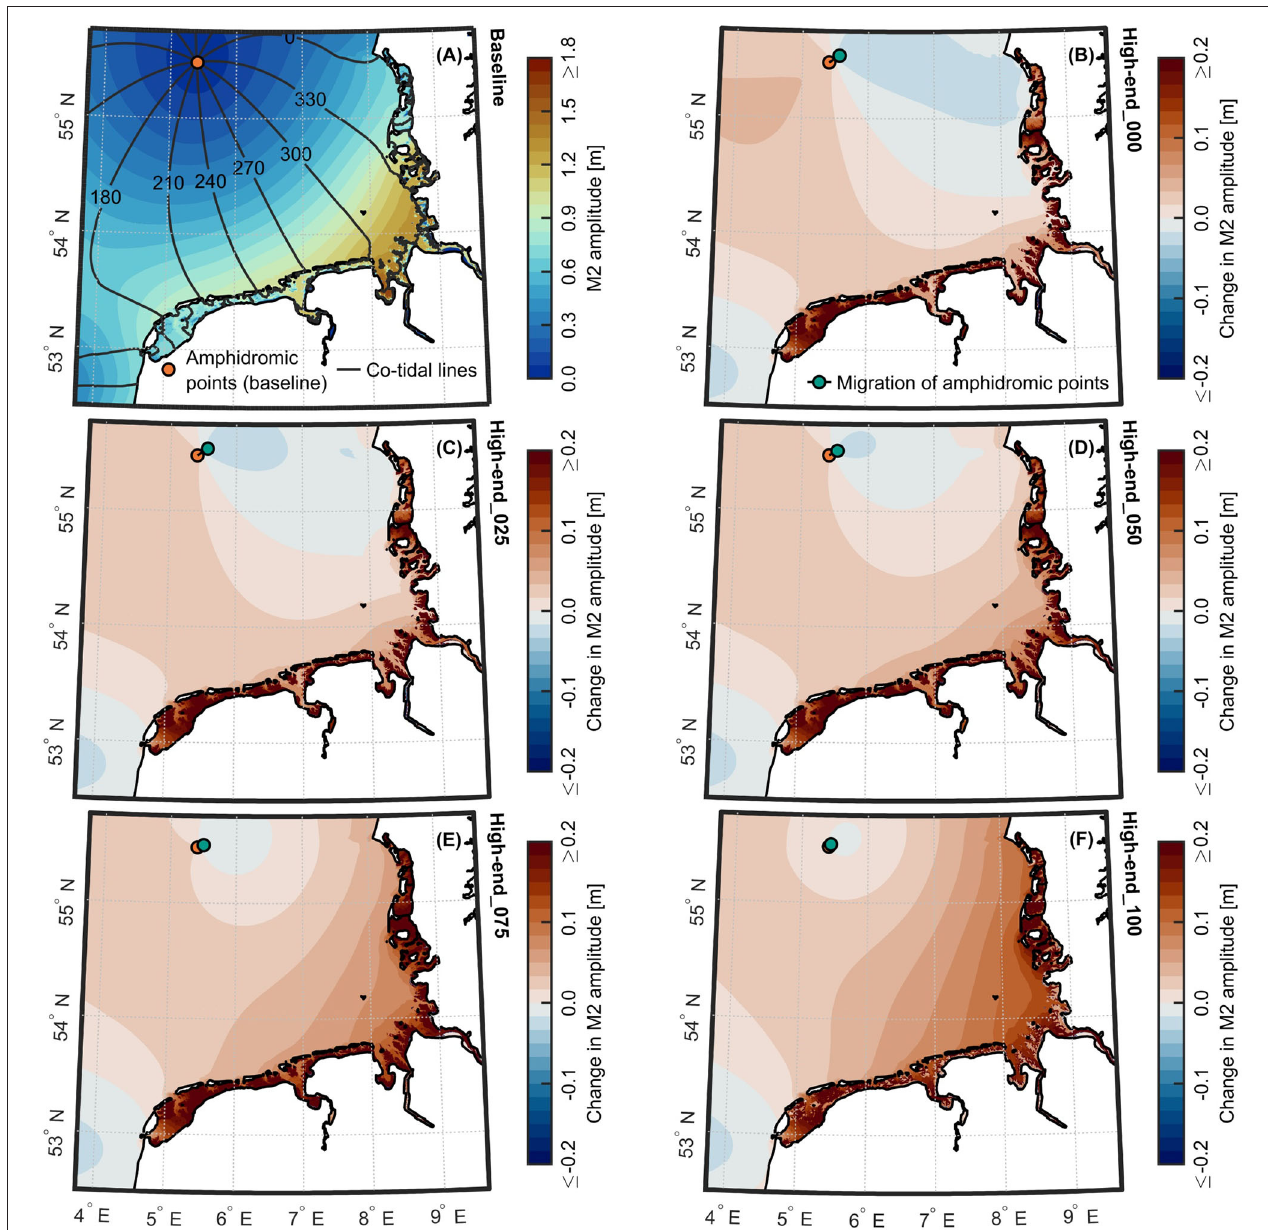
FIGURE 12 | M2 amplitudes for the Wadden Sea resulting from the combinations of 2.0m SLR projection and various cumulative rates of vertical accretion. (A) Map of M2 amplitudes for the Wadden Sea for the baseline scenario, according to the 3-month period from September 1 to December 1, 2012. Relative changes in M2 amplitudes for scenarios (B) high-end_000, (C) high-end_025, (D) high-end_050, (E) high-end_075, and (F) high-end_100. Green dots indicate movements of amphidromic points in relation to the baseline scenario (orange